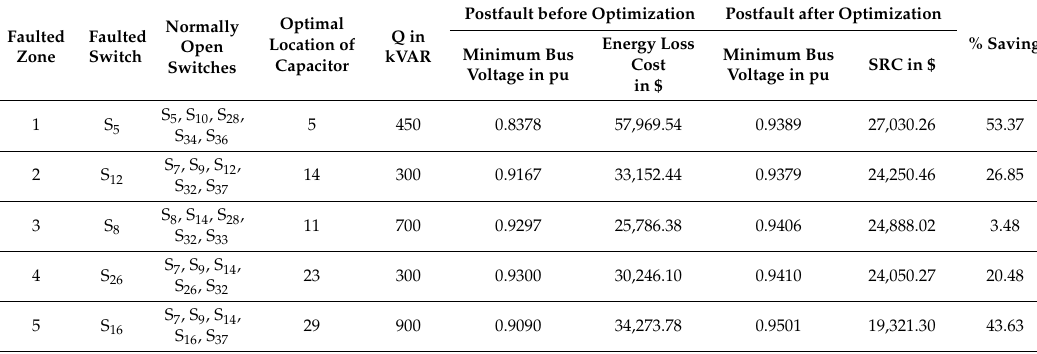
Table 3. Summary of results for test case 1 under SFC at di ff erent